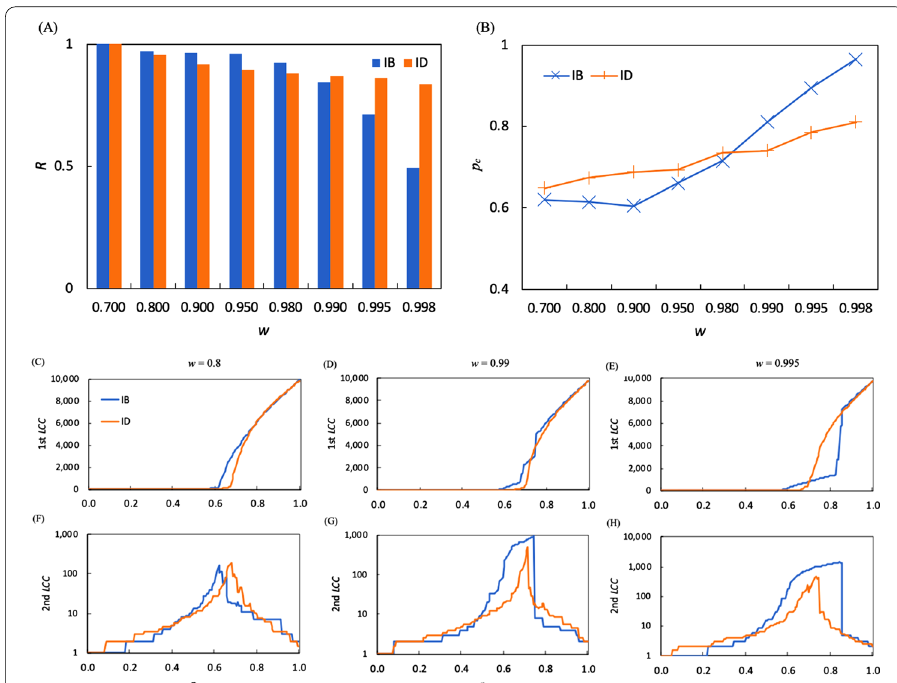
Fig. 5 Simulation result for modular networks generated from BA network with N A The critical occupation probability p c and B the single value network robustness ( R ) as a function of the re‑wiring ratio w . The trend is clear, when w > 0.98, p cIB becomes higher than p cID and R IB becomes smaller than R ID , showing that the network becomes more vulnerable to the betweenness‑based strategy than the degree‑based strategy. C – H Size of the 1st LCC and the 2nd LCC as a function of the occupation probability p with three different value of w : 0.8 ( C , F ), 0.99 ( D , G ) and 0.995 ( E , H ). All results are averaged over